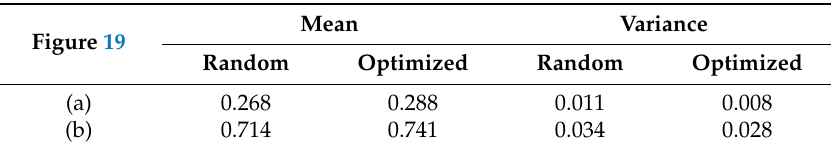
Table 14. Mean and variance of curves in Figure